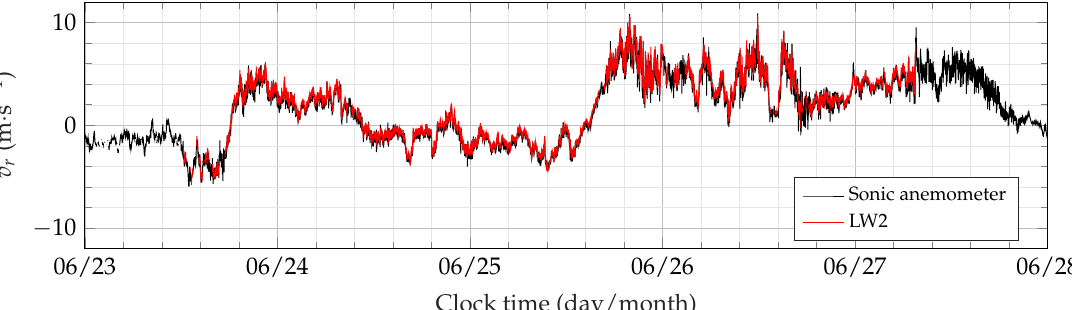
Figure 5. Along-beam velocity recorded during the last four days of the measurement campaign by LW2, and the sonic anemometer located 2.3km North of the lidar unit, at a height of 83m above the mean sea level. For illustrative purposes only, the sampling time is increased to